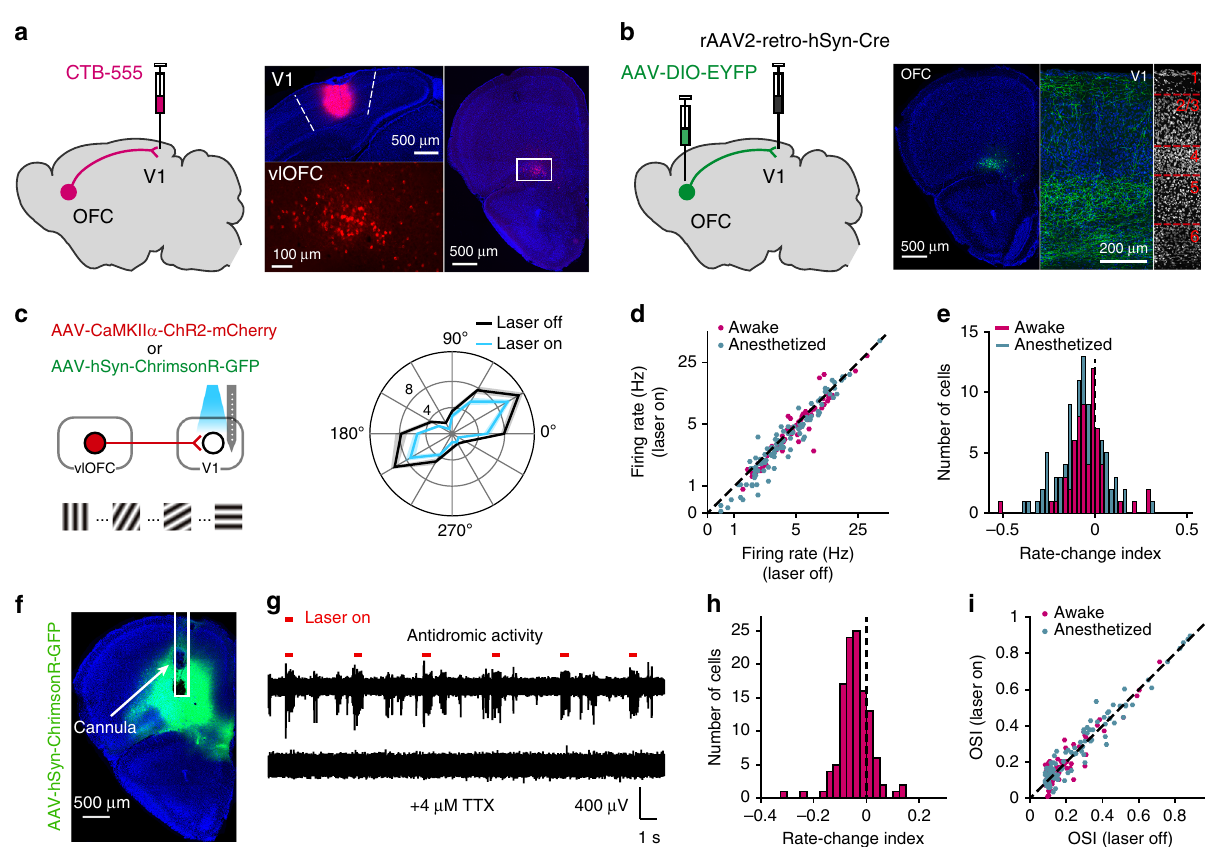
Fig. 1 Activating OFC projection to V1 reduces response amplitude of V1 neurons. a Left, schematic of CTB injection in V1. Right, Representative fl uorescence images of CTB injection in V1 and retrograde labeled neurons in the ventrolateral OFC. b Left, virus strategy to visualize OFC axons in V1. Right, representative fl uorescence images of V1-projecting OFC neurons and their terminals in V1. The experiments in a and b were repeated >3 times with similar results. c Left, schematic of measuring V1 visual responses with and without activating OFC axons. Right, tuning curves of a V1 neuron with (blue) and without (black) laser stimulation of OFC axons. d Mean fi ring rate ( fi ring rate averaged overall orientations) of V1 neurons with laser-on vs. laser-off. Anesthetized mice (blue): P = 5.2 × 10 − 6 , n = 102 neurons; awake mice (magenta): P = 6.53 × 10 − 5 , n = 62 neurons. e Distribution of rate change indexes for V1 neurons in anesthetized ( P = 2.6 × 10 − 8 ) and awake mice ( P = 3.81 × 10 − 5 ). f TTX was infused to the OFC, in which AAV-hSyn-ChrimsonR-GFP had been injected, to block the antidromic spikes induced by laser stimulation in V1. White rectangle shows the placement of the cannula. g TTX infusion into the OFC abolished multi-unit activity in the OFC evoked by laser stimulation in V1. Upper trace, without TTX; Lower trace, with TTX infusion into the OFC. h Distribution of rate change indexes of V1 neurons recorded with TTX infusion into the OFC. P = 2.33 × 10 − 12 , n = 118 neurons from awake mice. i , Orientation selectivity index (OSI) with laser-on vs. laser-off. Anesthetized mice (blue): P = 0.36, n = 102; awake mice (magenta): P = 0.99, n = 62. For d , e , h , i AAV-CaMKII α -hChR2 (H134R)-mCherry and AAV-hSyn-ChrimsonR-GFP were injected in the OFC for anesthetized and awake mice, respectively. Wilcoxon two-sided signed rank test. For d , e , h , i source data are provided as a Source Data fi le. Shadings, mean ±